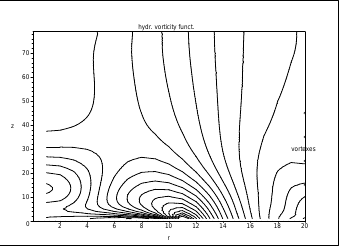
Figure 9. Distribution of the circu- lation with a ring input, A = 0 ,Re = 100 ,Ω 1 = 0 ,Ω 2 = 1 .